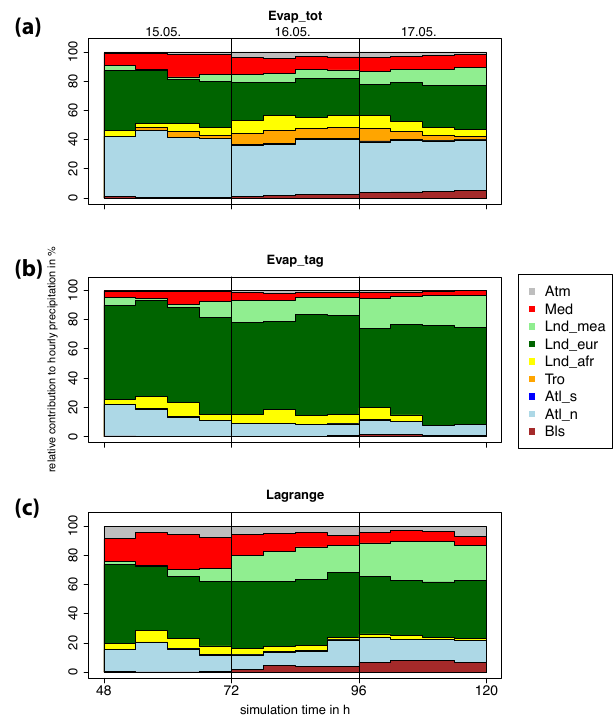
Figure 9. Relative contribution of the different moisture sources to the hourly precipitation in the target region in eastern Europe between 00:00UTC on 15 May and 00:00UTC on 18 May 2010. Results are shown from (a) the COSMO tagging simulation with Evap_tot parameterisation, (b) the COSMO tagging simulation with Evap_tag parameterisation and (c) the Lagrangian moisture source diagnostics.